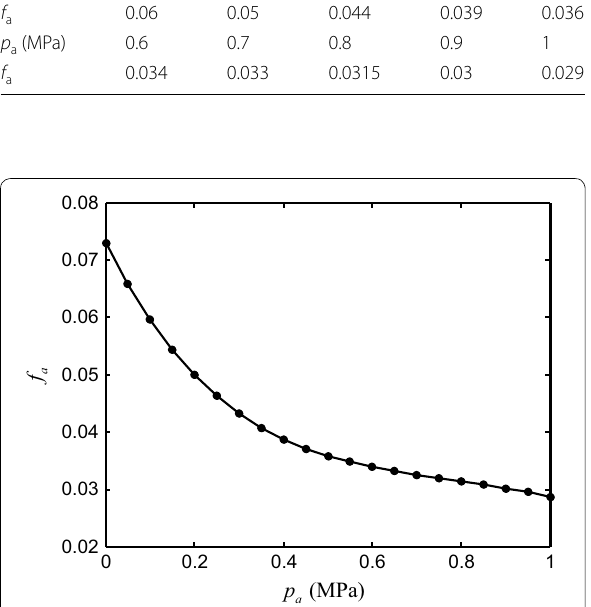
Figure 8 Variation of contact frictional coefficient with pressure